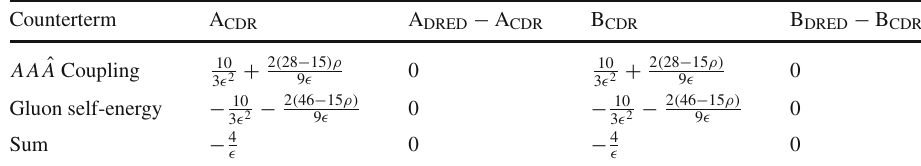
Table 18 Results for fermionic part of QCD using CDR and